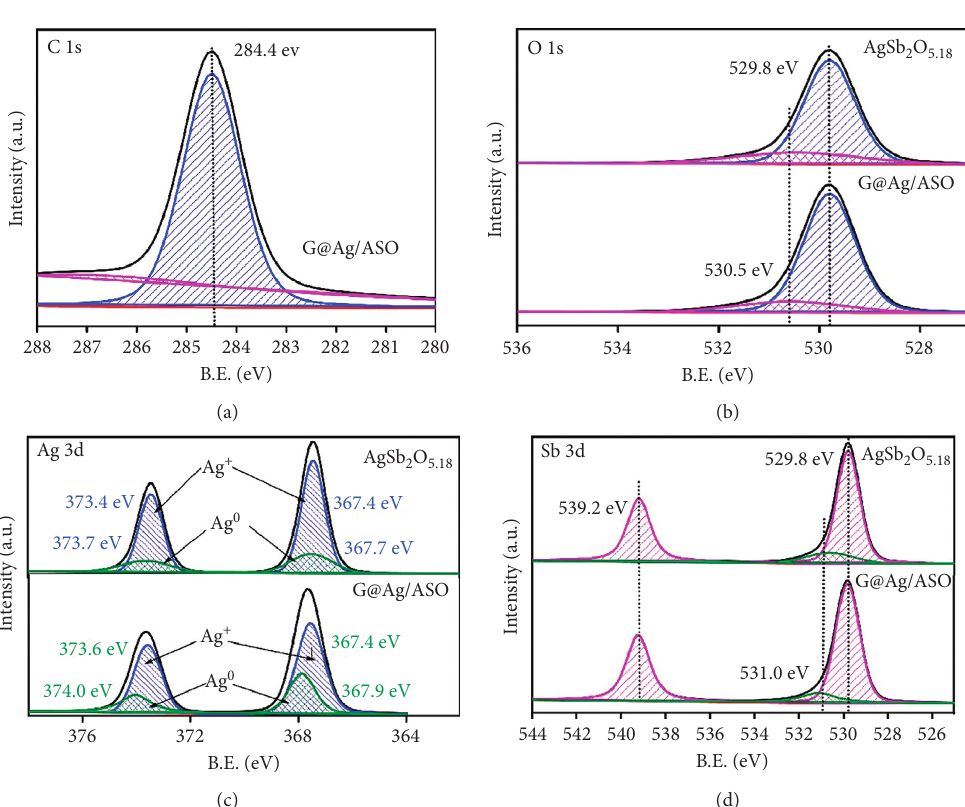
Figure 5: XPS spectrum of (a) C 1s, (b) Ag 3d, (c) O 1s, and (d) Sb 3d for both of AgSb